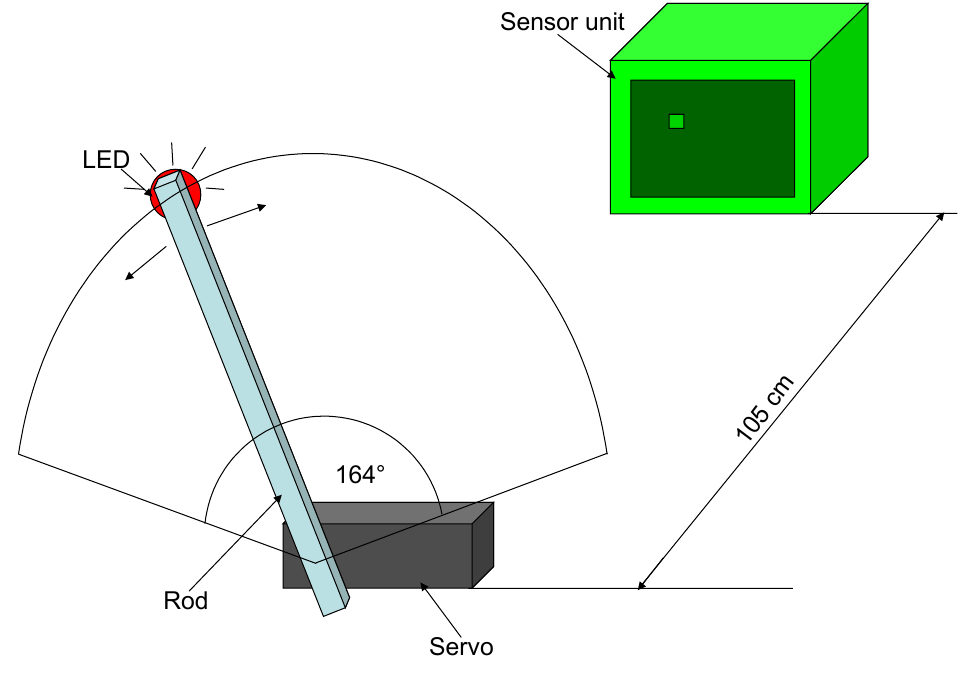
Figure 14. Tracking test